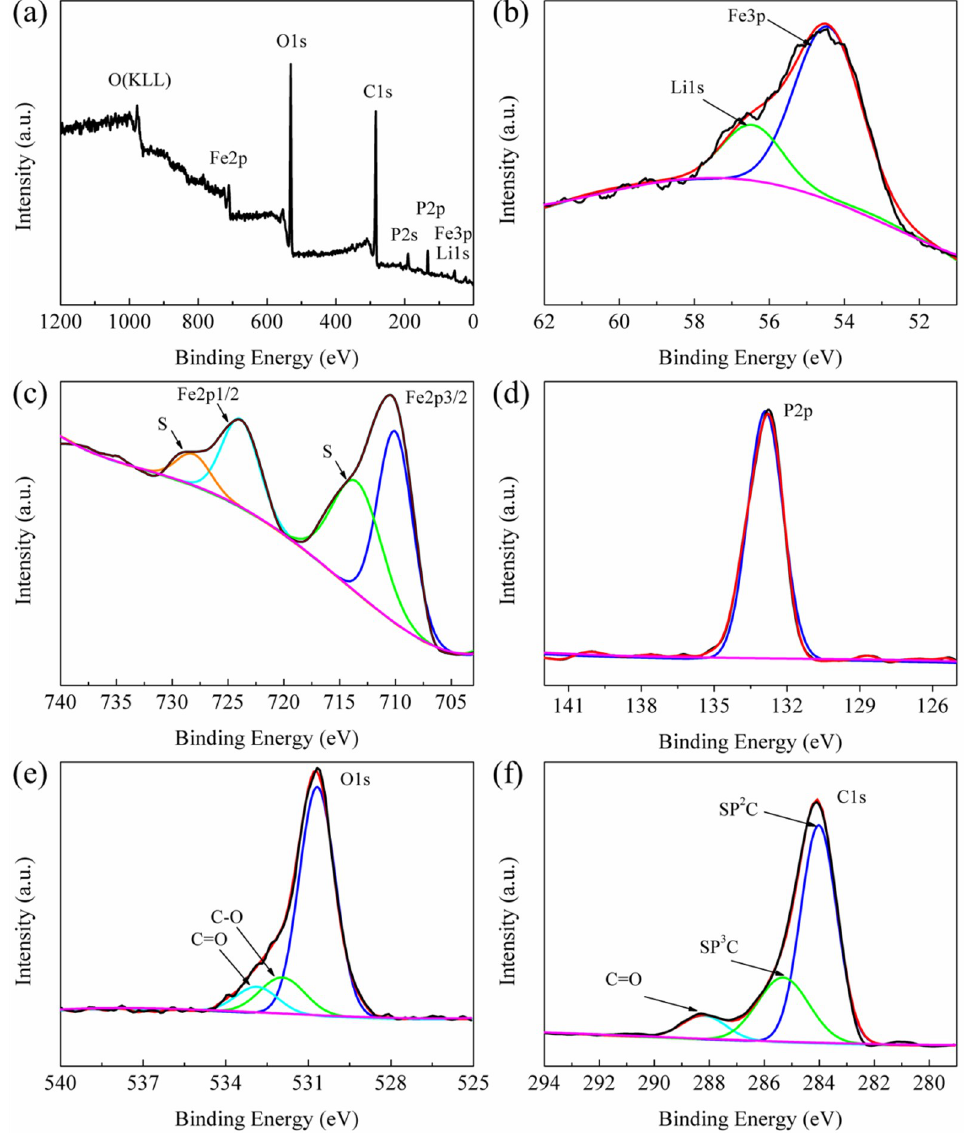
Figure 4. XPS survey of LiFePO 4 /C composite ( a ); high resolution XPS spectrum of: Li 1s ( b ); Fe 2p ( c ); P 2p ( d ); O 1s ( e ); and C 1s ( f ) for LiFePO 4 /C composite.